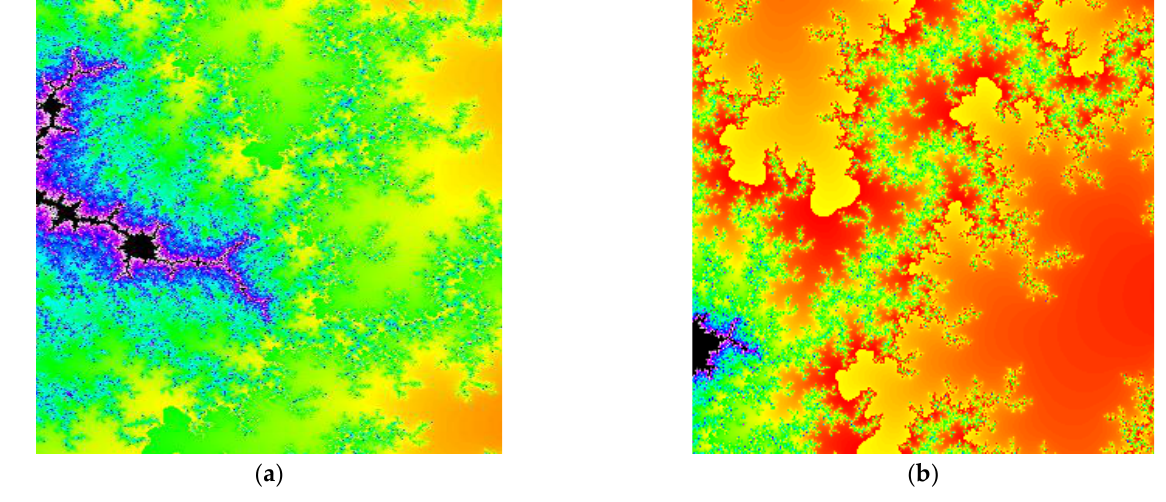
Figure 16. Example of Mandelbrot images generated by the developed tool. ( a ) Primary image for Mandelbrot generation with out-of-set black areas. ( b ) Focused image for the image in a specific Mandelbrot model.